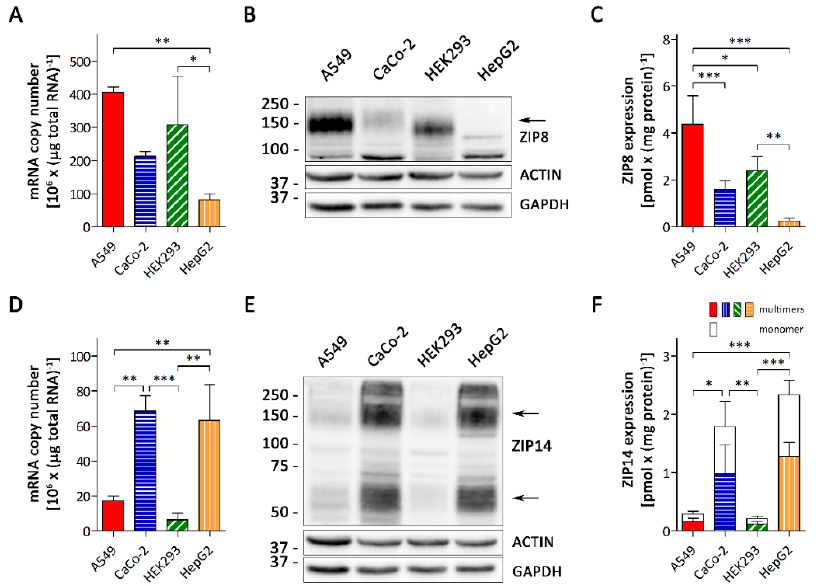
Figure 1. Expression of ZIP8 and ZIP14 in human cell lines. ( A ) ZIP8 and ( D ) ZIP14 mRNA copy number of A549, CaCo-2, HEK293, and HepG2 cells. Data are presented as means ± SD from three independent experiments. Statistical analysis was performed using one-way ANOVA followed by the Bonferroni post-hoc test with * p < 0.05, ** p < 0.01, and *** p < 0.001. ( B ) ZIP8 and ( E ) ZIP14 immunoblot of whole-cell lysates of A549, CaCo-2, HEK293, and HepG2 cells. Both β -ACTIN and GAPDH were used as loading controls. Specific bands for ZIP8 and ZIP14 (monomers and multimers) are indicated by arrows. Specific amounts of ( C ) ZIP8 and ( F ) ZIP14 (monomeric + multimeric forms) in A549, CaCo-2, HEK293, and HepG2 were determined using the fusion proteins that were used for the generation of the ZIP8- and ZIP14-antibodies as quantitative markers (see Figure S3 for details). Data are presented as means ± SD from four independent experiments. Statistical analysis was performed using one-way ANOVA followed by the Bonferroni post-hoc test with * p < 0.05, ** p < 0.01, and *** p <